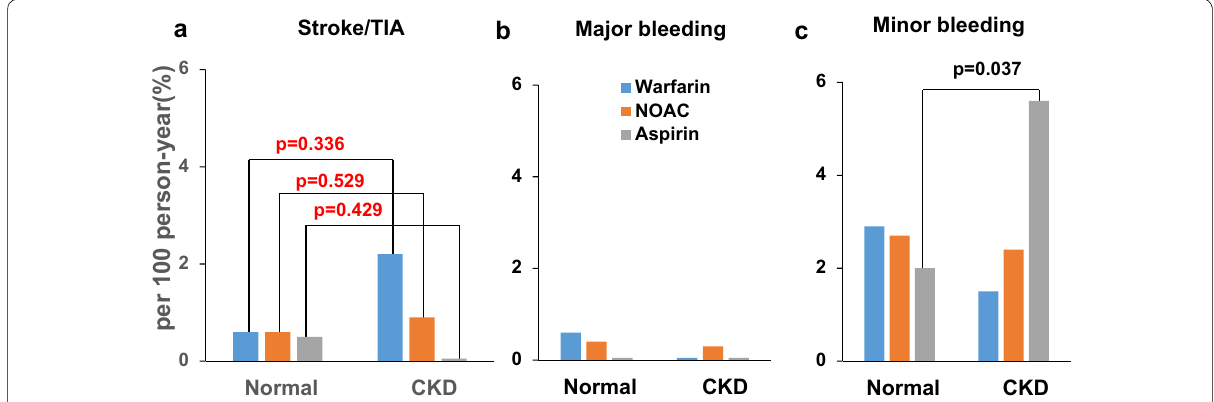
Fig. 7 Comparison of adverse outcome according to oral anticoagulation strategies between normal and CKD patients. Aspirin significantly increased minor bleeding in CKD patients compared with the normal group ( p